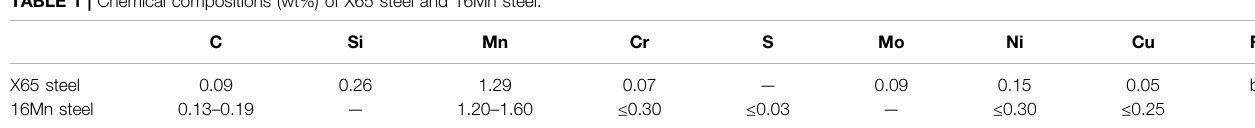
TABLE 1 | Chemical compositions (wt%) of X65 steel and 16Mn